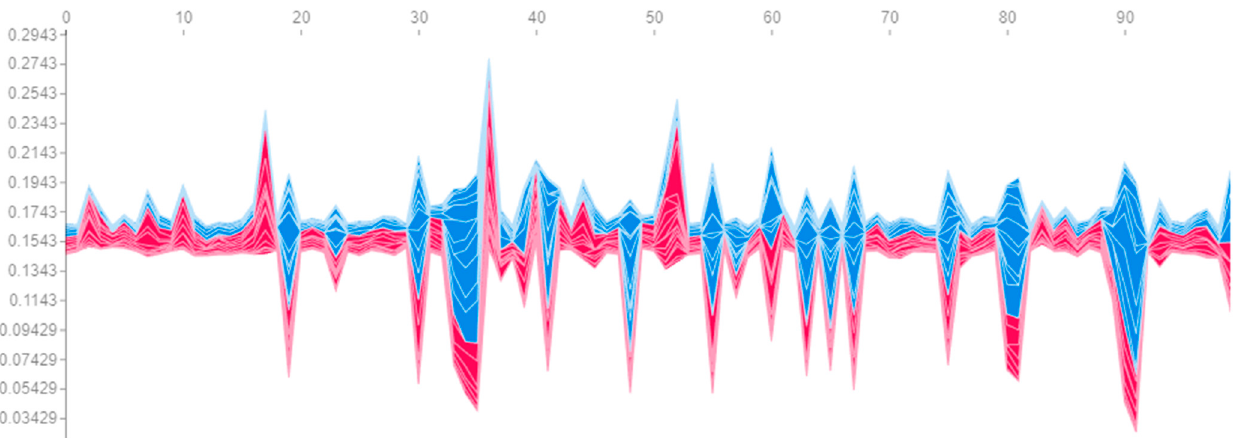
Figure 13. Contribution of features to the probability of engine failure in the last (21st) time window.